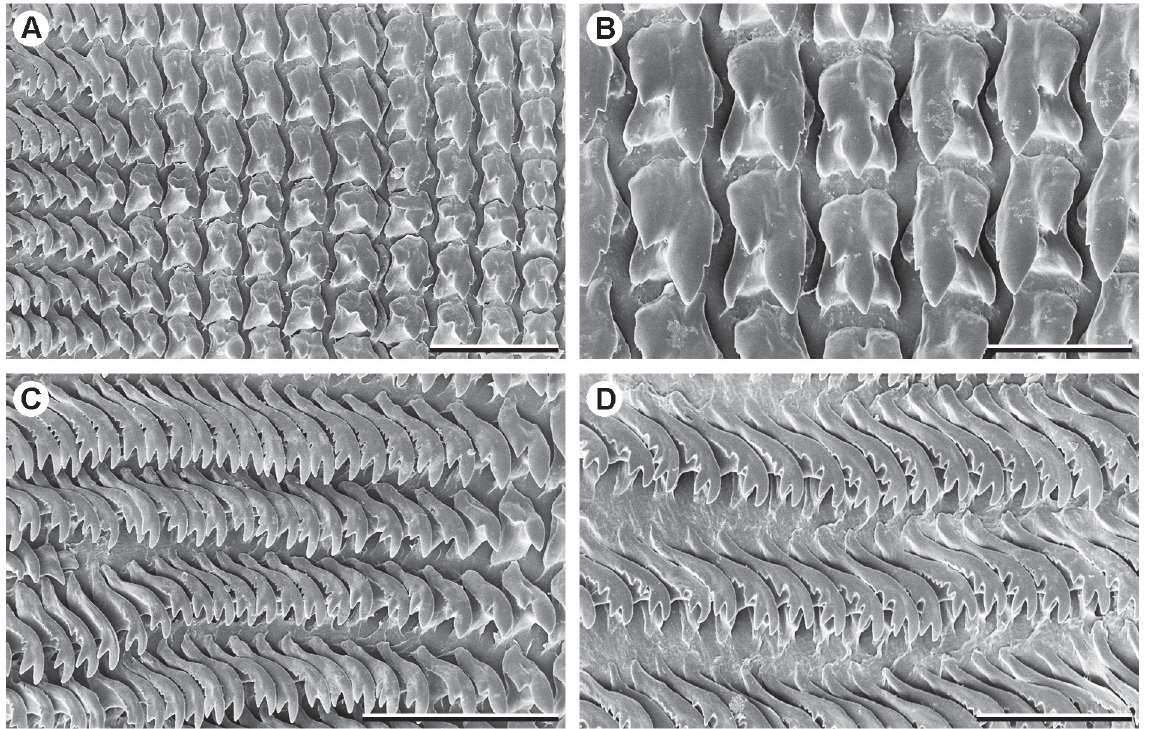
Fig. 6. Ptilototheca soutpansbergensis gen. et sp. nov., radula, holotype (NMSA V5567/T4069). A . Rachidian and left lateral teeth. B . Rachidian and innermost lateral teeth. C . Inner left marginal teeth. D . Outer left marginal teeth. Scale bars: A, C = 50 µm; B, D =